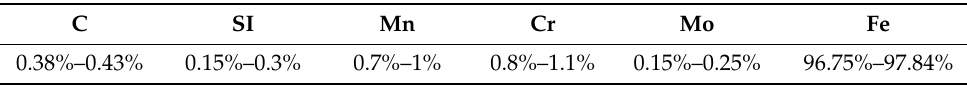
Table 2. Chemical composite (wt. %) of AISI 4140.